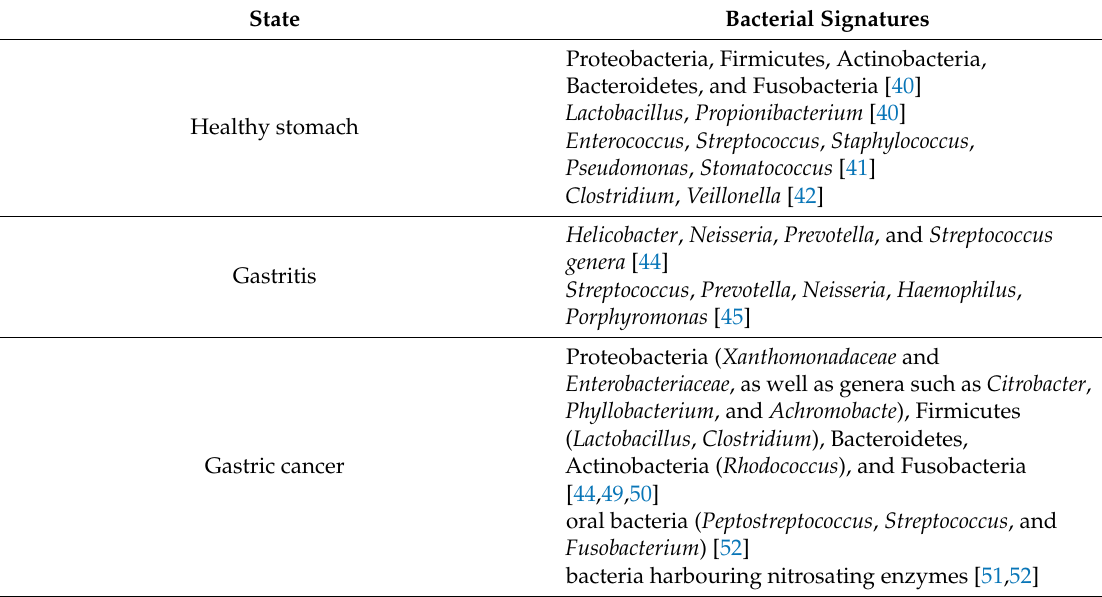
Table 3. Bacterial signatures of healthy stomach microbiome as well as gastritis and cancer related stomach